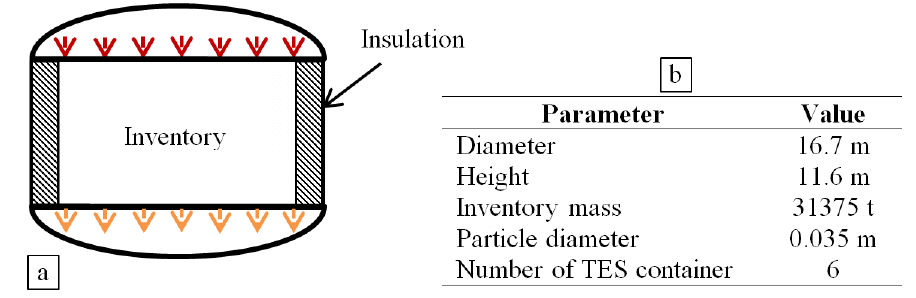
Figure 2. Sketch of the lead concept ( a ) and its specifications ( b ) [27].